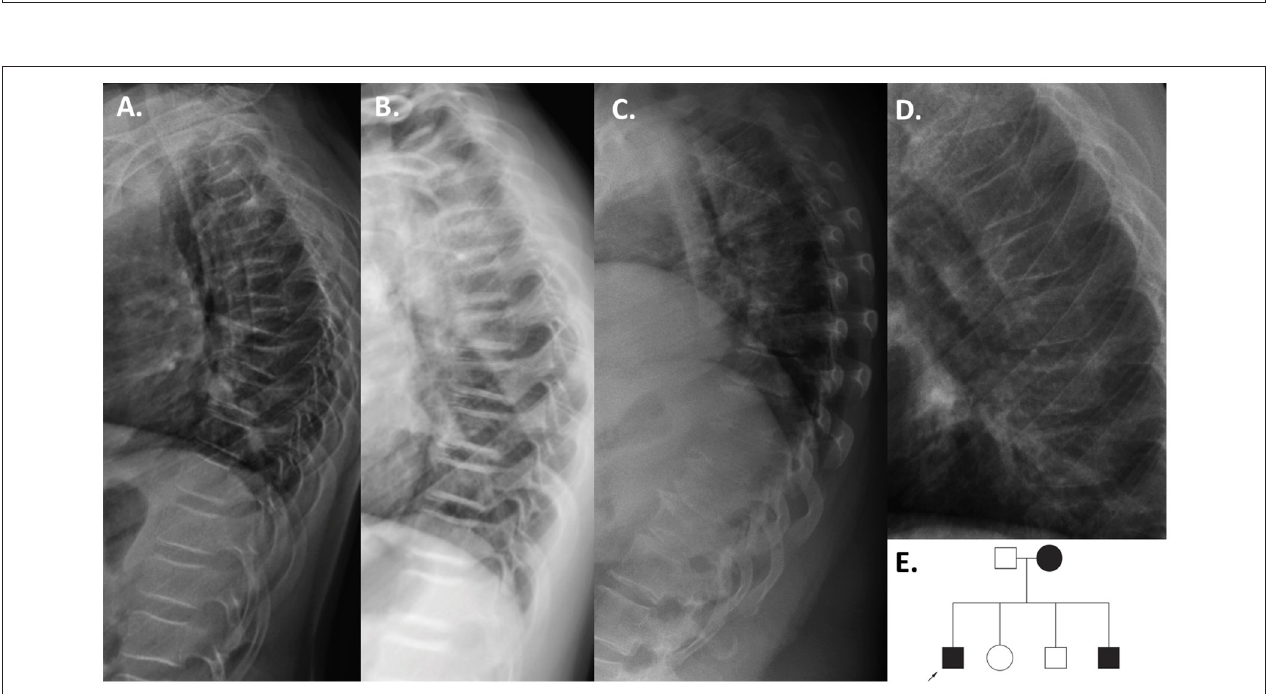
FIGURE 3 | Patients with the PLS3 duplication. Thoracic radiographs of the index patient before bisphosphonate treatment at age 11 years (A) , and after 2 years of bisphosphonate treatment at 13 years (B) showing multiple compressed vertebrae and improvement in vertebral shape after bisphosphonate treatment. The mutation-positive mother at 40 years (C) and younger brother at 6 years (D) also had compression fractures. Pedigree of the family (E) .